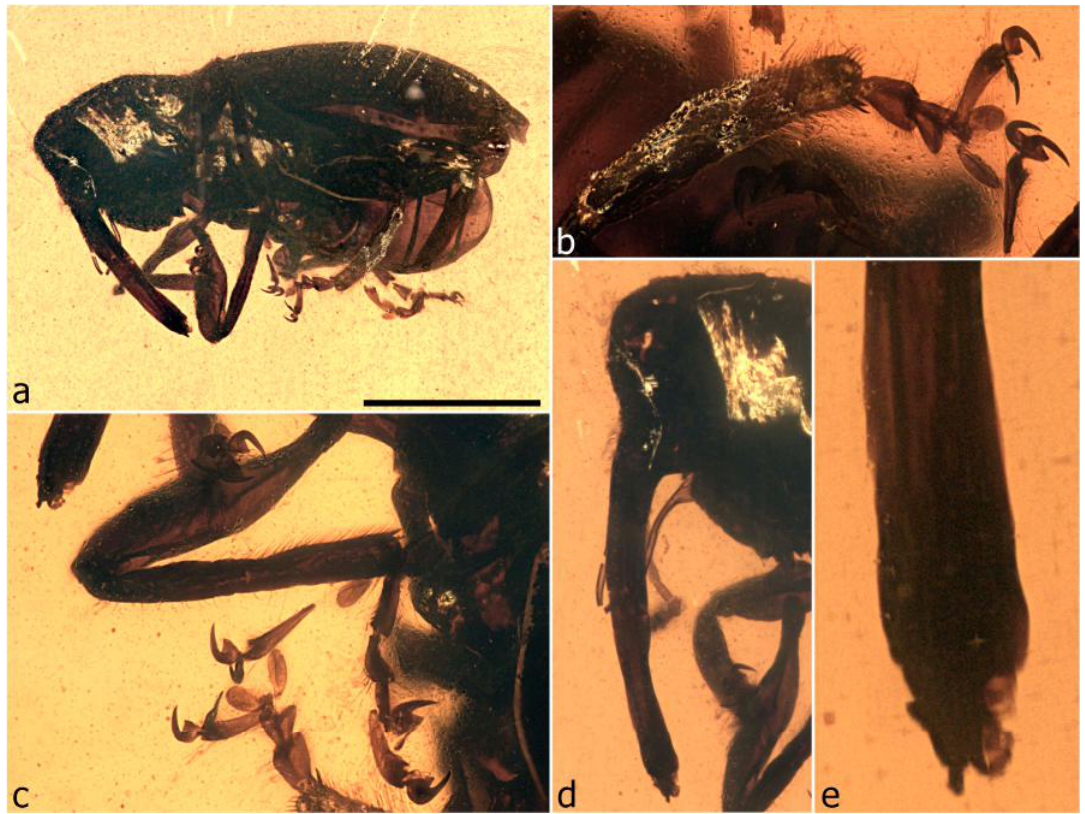
Figure 88. Bowangius glabratus sp. n., holotype. Habitus, left lateral ( a ); left metatibia ( b ); protibia and tarsi ( c ); head and rostrum, left lateral ( d ); apical part of rostrum, left lateral ( e ). Scale bar: 1.0 mm (a). Bowangius sp. 4 (Figure 89)